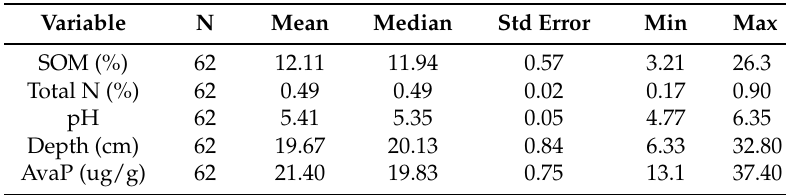
Table 1. Descriptive statistics of soil